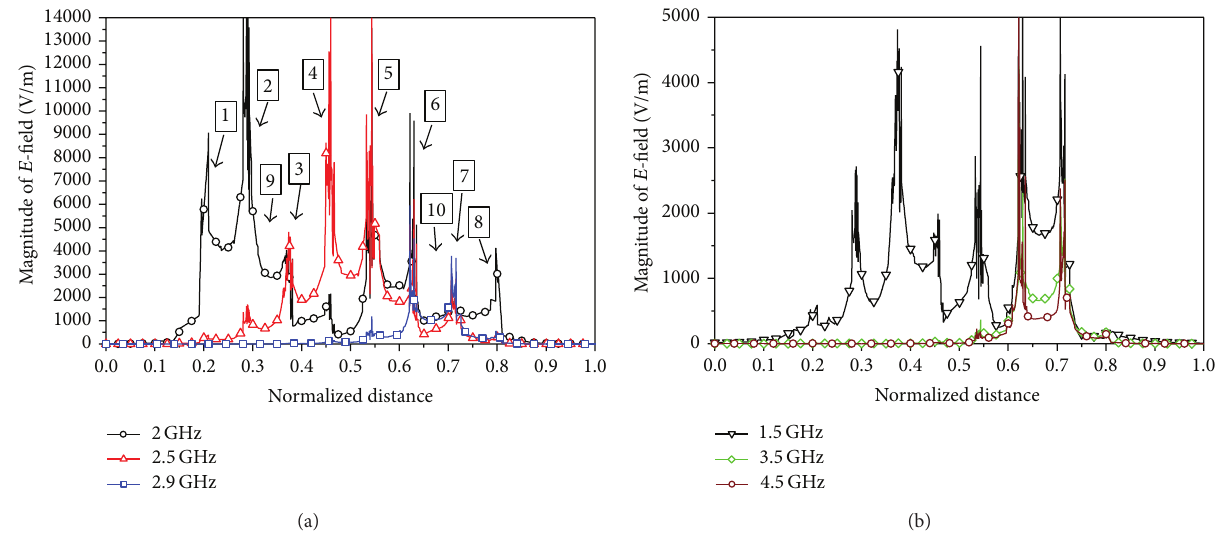
Figure 15: (a) and (b) Total 𝐸 -fields along the assessing Line 1 at different frequencies. Line 1 shown in Figure 14 is distant from the EBG- patterned parallel planes by 0.2 mm. In the normalized scale, Label 1 shows the left edge opening, label 8 shows the right edge opening, and labels 2–7 show the 1st to 6th meandered-pattern openings, respectively. Labels 9 and 10 show the locations of Port 1 and Port 2, respectively.